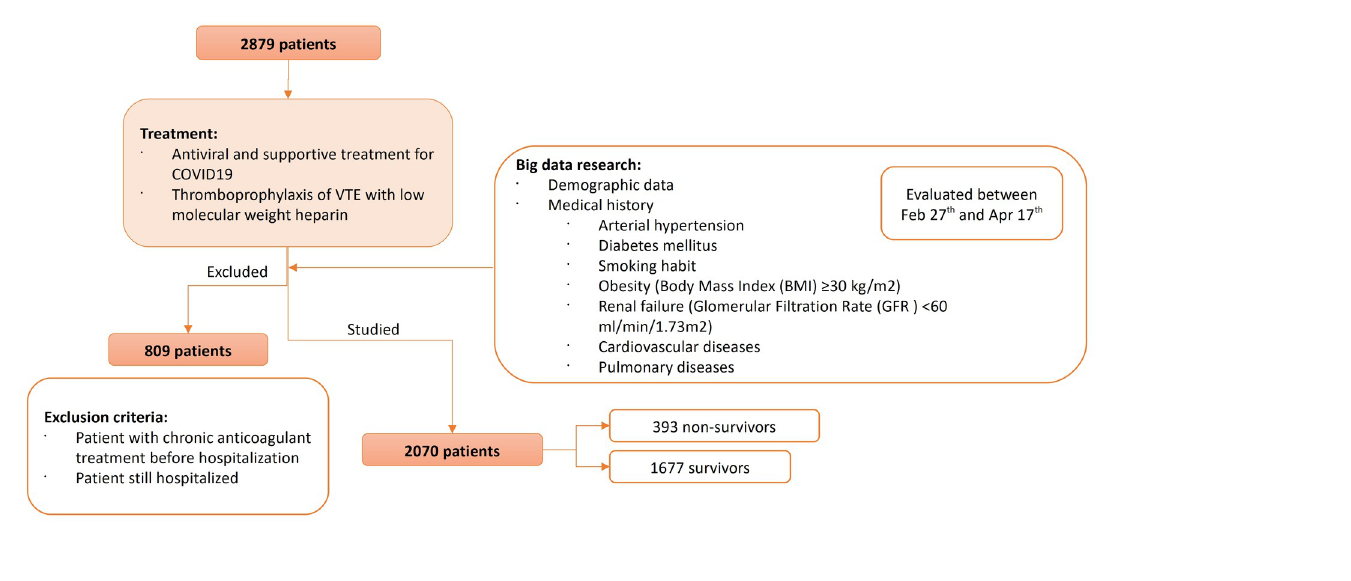
Fig 1. Flow diagram of the sample selection and study